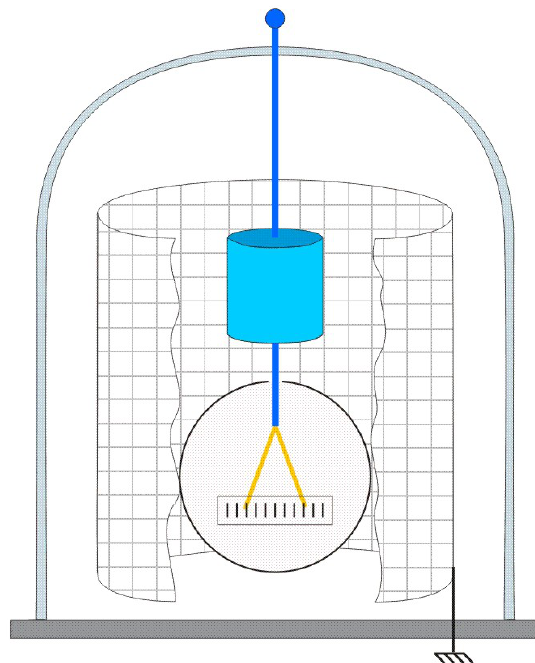
Figure 1. Schematic sketch of a bifilar (yellow) electrometer as used for radioactivity research. A radioactive sample was placed in the vessel (glass) and ionized the air therein. The electroscope was charged from outside, and the current flowing between the cylinder electrode (blue) and the surrounding wire mesh was derived from the charge decrease, read from the electroscope scale (adapted from the Glasglockenapparat of Geitel,